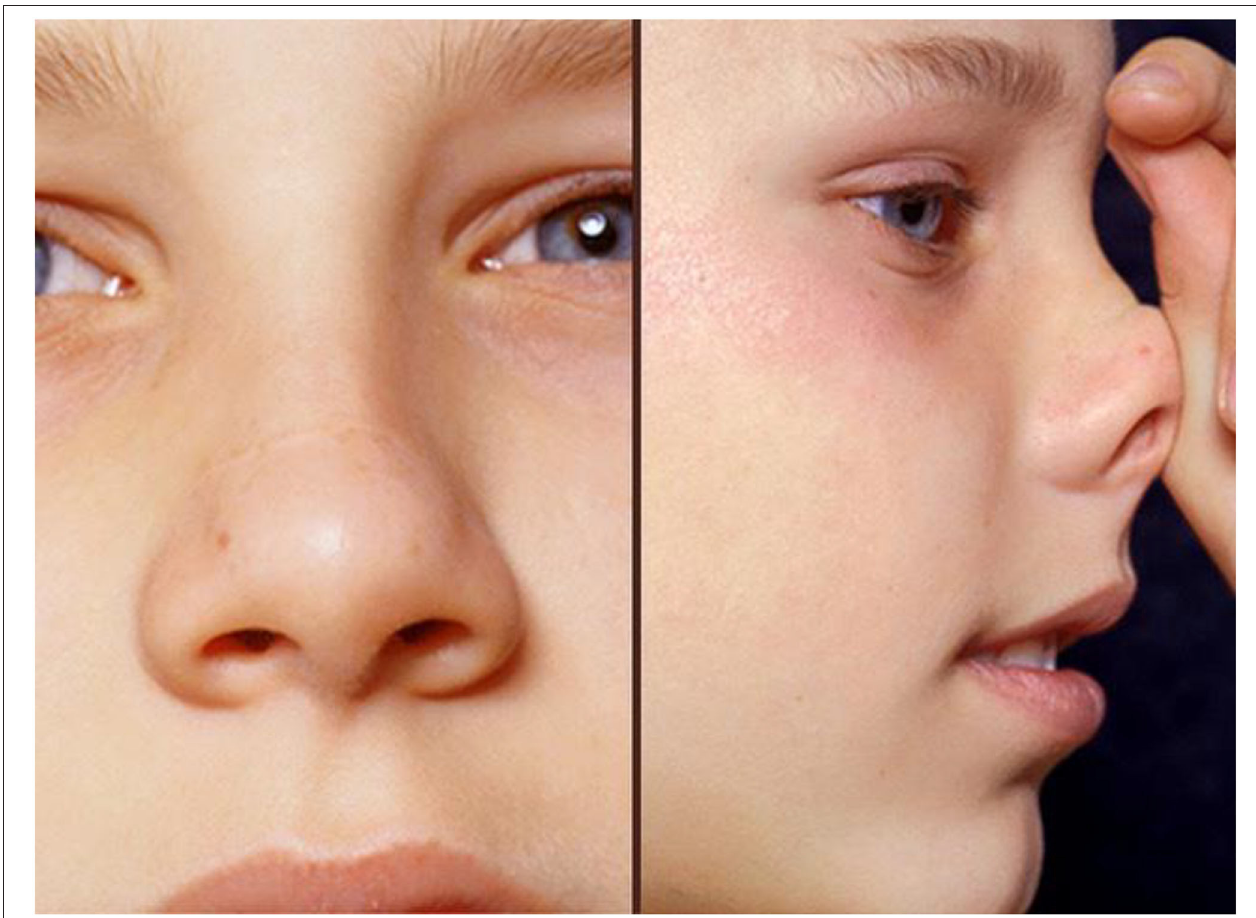
FIGURE 4 | This child shows typical facial changes associated with allergy: he is pale, mouth breathing, with dark circles beneath eyes, a transverse nasal crease, double eye creases and loss of the lateral eyebrow. He is seen giving an allergic salute in the right-hand photo.